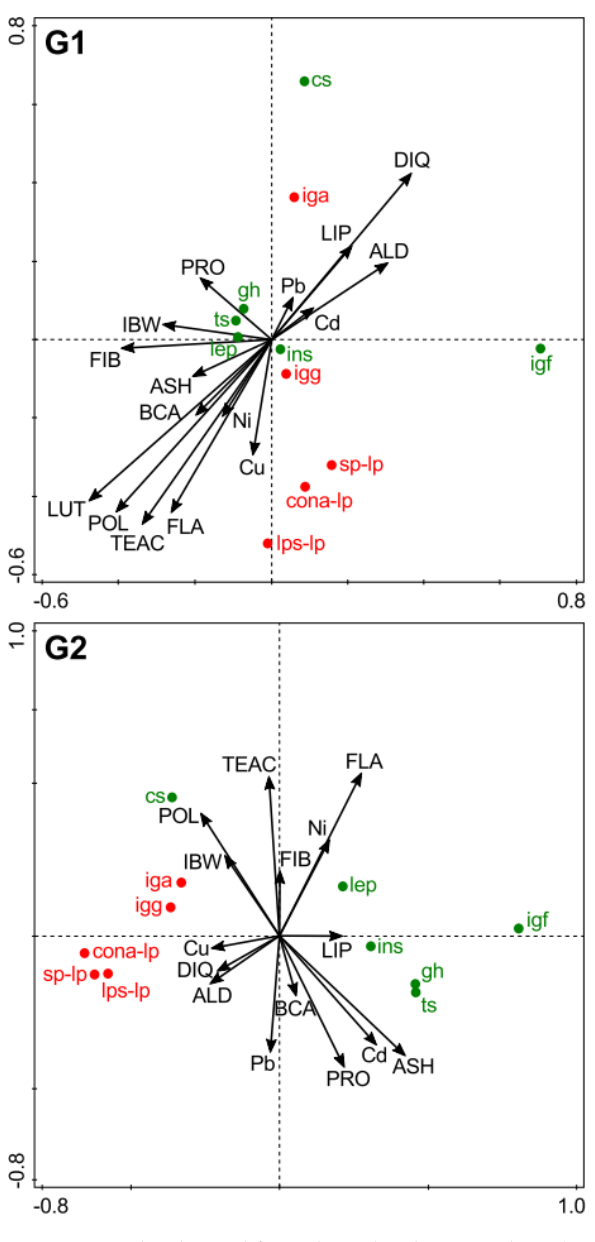
Figure 13. Biplot derived from the redundancy analysis (RDA) showing the relationships between the concentrations of experimental feed components/parameters (continuous explanatory variables) and selected hormones and immunological parameters (response variables) in the first (G1) and second (G2) generation of rats, data from [143]. ASH, ash; LIP, lipids; PRO, protein; FIB, fiber; BCA, β -carotene; FLA, flavonols; LUT, lutein; POL, polyphenols; Cu, copper; ALD, aldicarb and DIQ, diquat; Cd, cadmium; Ni, nickel; Pb, lead; TEAC, feed antioxidant activity; IBW, initial body weight of rats at weaning, cs, corticosterone; gh, growth hormone; igf, insulin-like growth factor 1; lep, leptin; ins, insulin; ts, testosterone; iga, immunoglobulin A; igg, immunoglobulin G; sp-lp, sponta- neous lymphocyte proliferation; cona-lp, concanavalin A-stimulated lymphocyte proliferation; lps- lp, lipopolysaccharide-stimulated lymphocyte proliferation. There is mounting evidence that maternal dietary factors (including severe nutrient deficiencies, intakes of endocrine-disrupting chemicals/pesticides, polyphenols and other phytochemicals) may result in the epigenetic programming of endocrine and immune functions, and thereby affect the risk of several diseases, including atopic disease and can- cer development in subsequent generations [171–177]. One of the factorial rat dietary in- tervention studies therefore investigated the effects of contrasting fertilization and crop